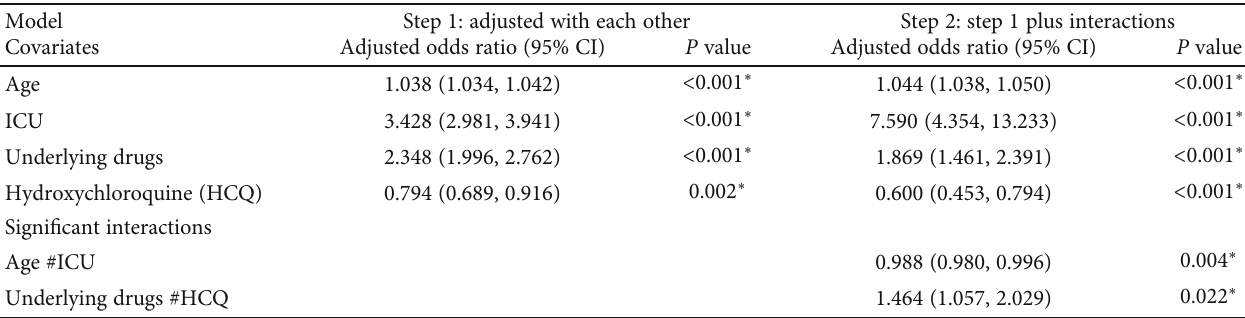
Figure 9: Association of hydroxichloroquine (a), prednisolon (b), hydrocortisone (c), dexamethasone (d), methylprednisolone (e), budesonide (f), IVIG (g), and vitamin C (h) with probability of death based on age and ICU admission (from logistic regression of Table 3, step 3). Table 4: Logistic regression model for association of hydroxychloroquine with death and the signi fi cant interactions.